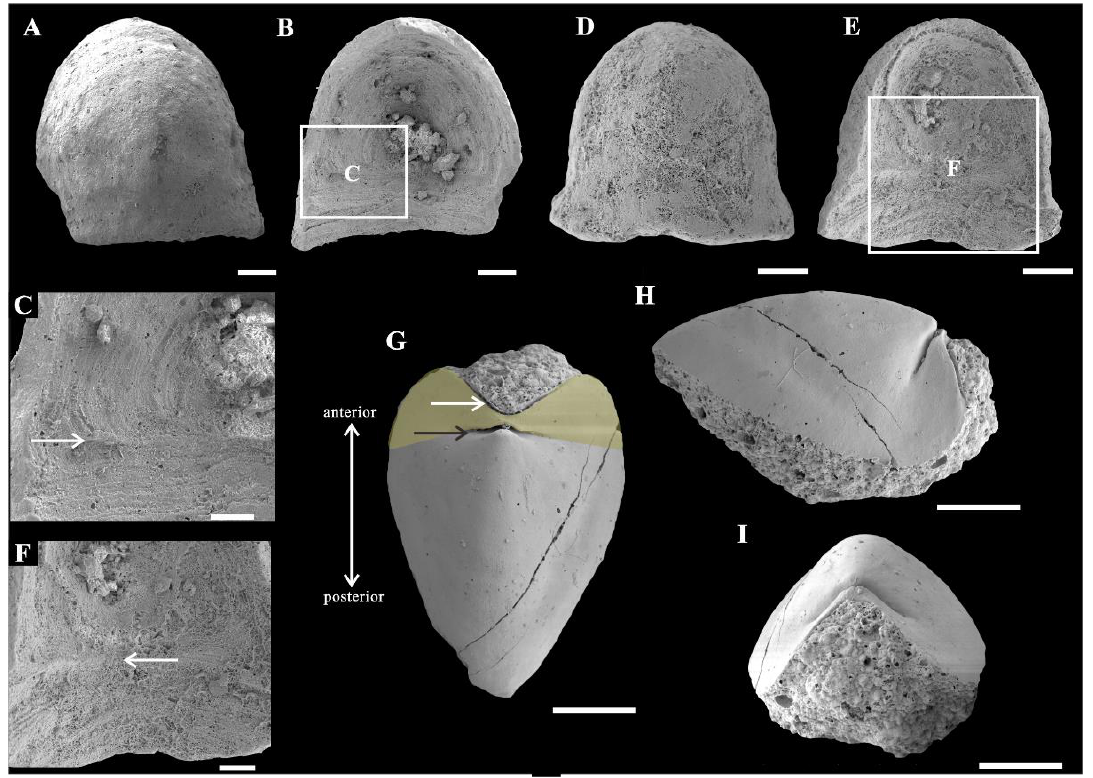
Figure 3. Ocruranus sclerites and Eohalobia sclerite from Member 5 of the Yanjiahe Formation. ( A – C ) Cast of Ocruranus sclerite, CUBar169 – 16; ( A ) exterior view; ( B ) interior view; ( C ) magnification of ( B ), showing dense wrinkles and transverse ridge. ( D – F ) Cast of Ocruranus sclerite, CURBar13 – 5; ( D ) exterior view; ( E ) interior view; ( F ) magnification of ( E ), showing dense wrinkles and transverse ridge. ( G – I ) Internal mold of Eohalobia sclerite, CUBar228 – 7; ( G ) dorsal view; ( H ) lateral view; ( I ) proximal view. White arrows show transverse ridge on inner surface of Ocruranus sclerites in ( C , F ) and V-shaped furrow on Eohalobia sclerite in ( G ). Black arrow shows transverse furrow on Eohalobia sclerite. Colored area shows butterfly shape. Scale bar: ( A , B , D , E ) 200 μm; ( C , F ) 100 μm; ( G – I ) 500 μm.